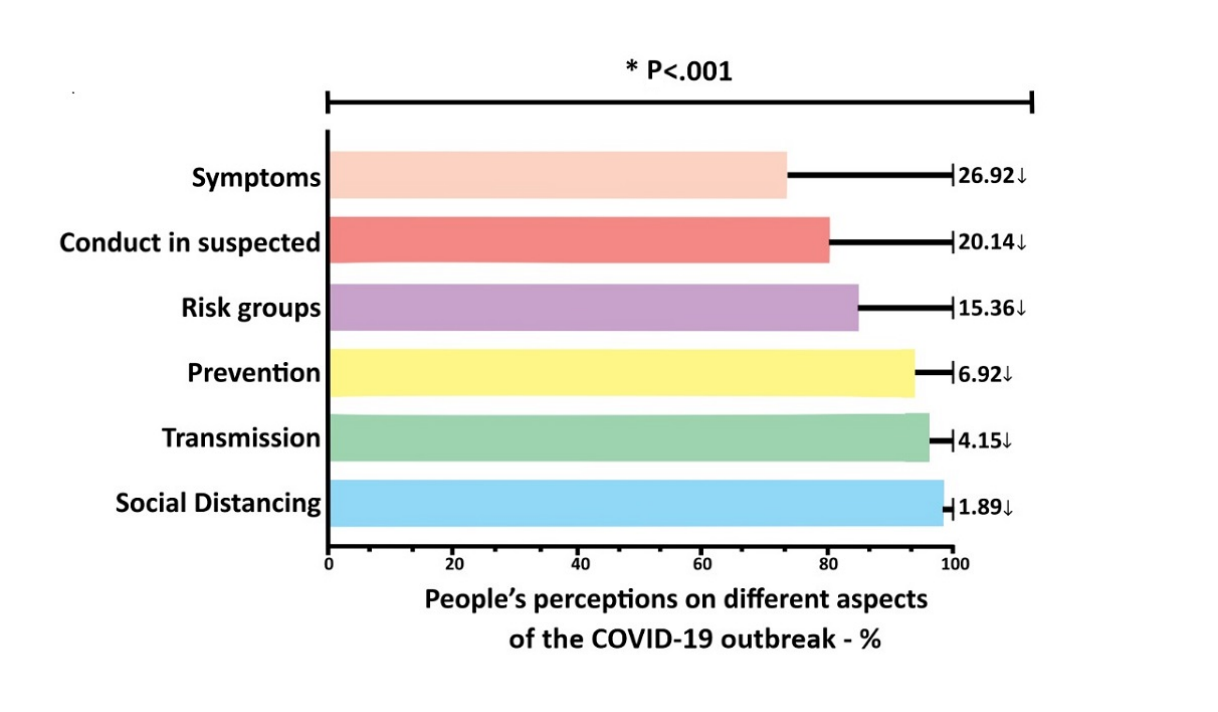
Figure 3. Distribution and association among COVID-19 health education indicators. The differences or similarities between the participants’ levels of correct answers on questions regarding the symptoms of COVID-19, the conduct of those suspected of SARS-CoV-2 infection, risk groups, disease prevention, disease transmission, and perception of social distancing. The relative distribution, in percentages, of the levels of right and wrong answers for each variable and comparisons between them is demonstrated. *Statistically significant differences between groups (Kruskal-Wallis test with Dunn multiple comparison